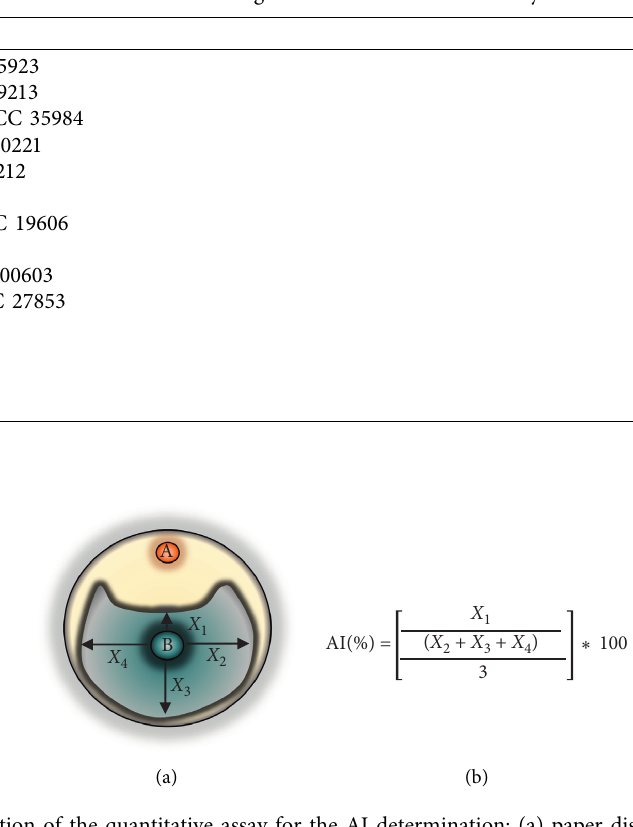
Table 1: Pathogenic strains used in this study.